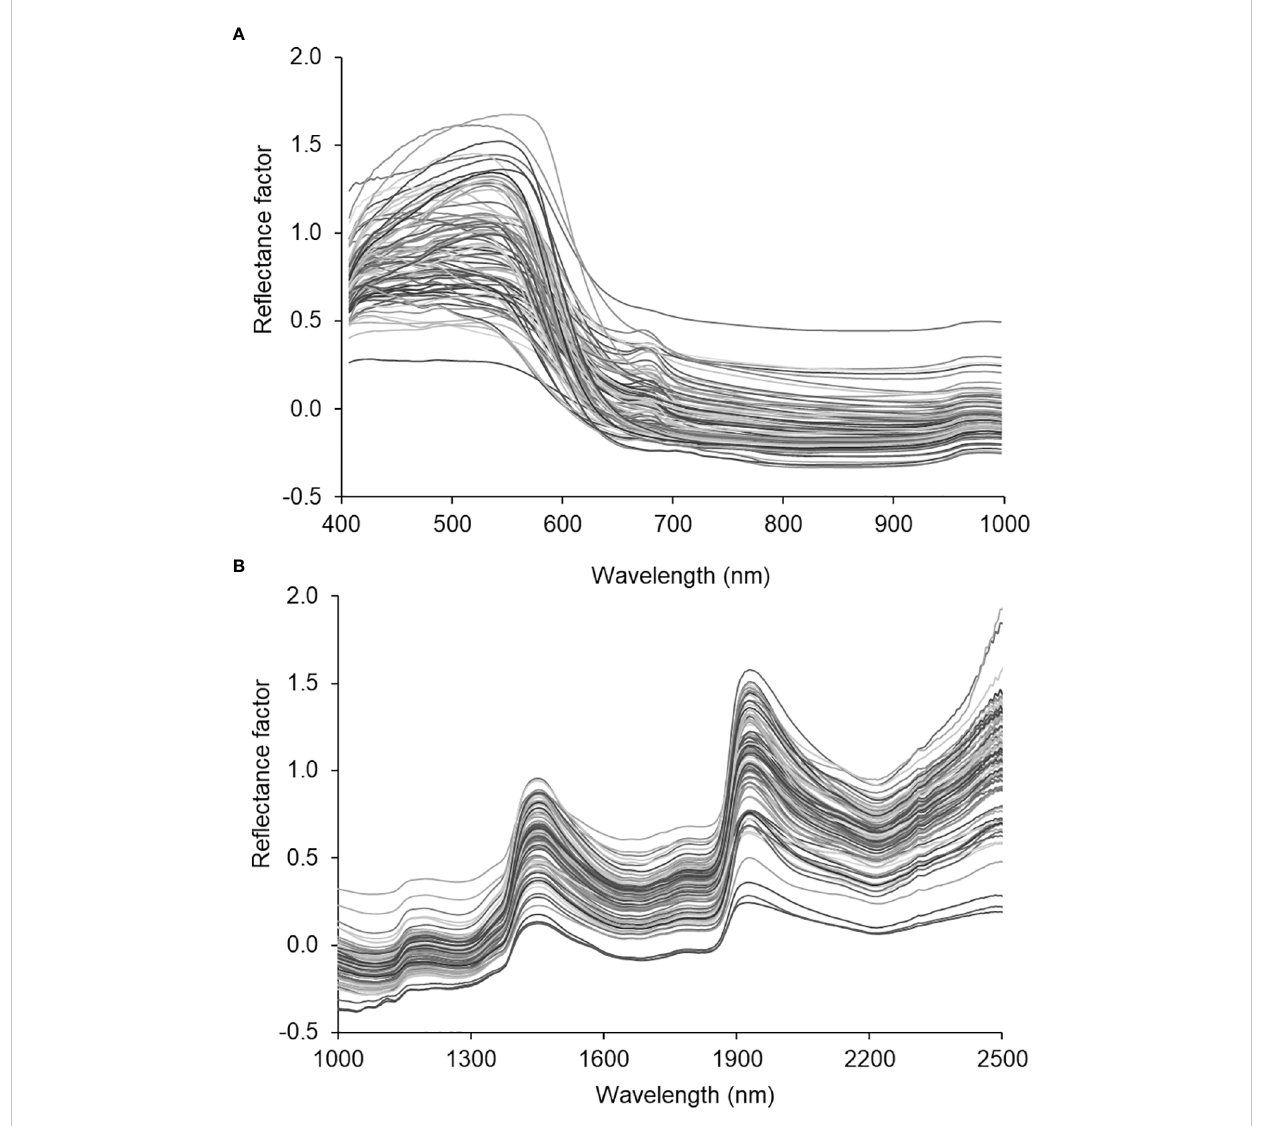
FIGURE 3 Spectral characteristic curves of the SWIRL data. average spectra of the hyperspectral images of all